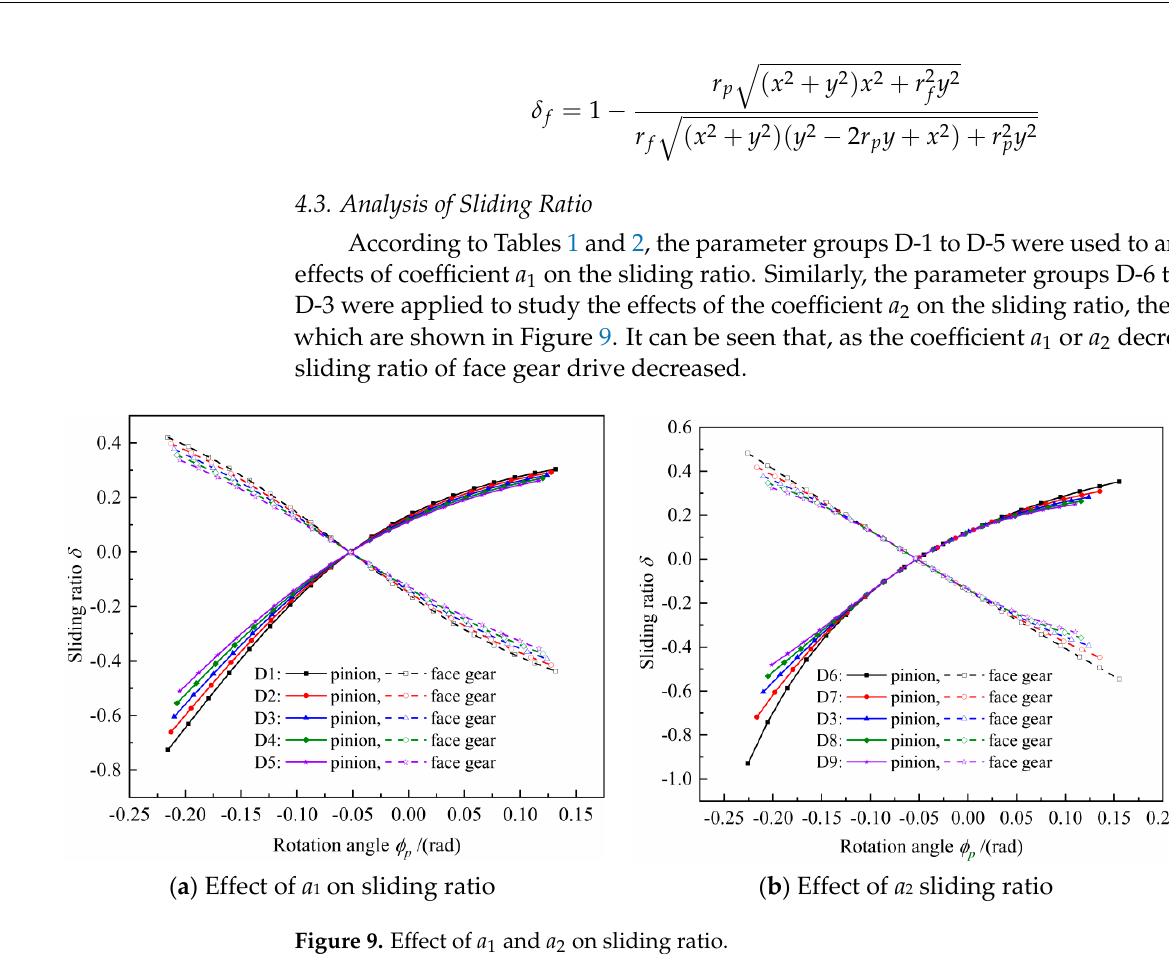
1 and a 2 on sliding ratio.